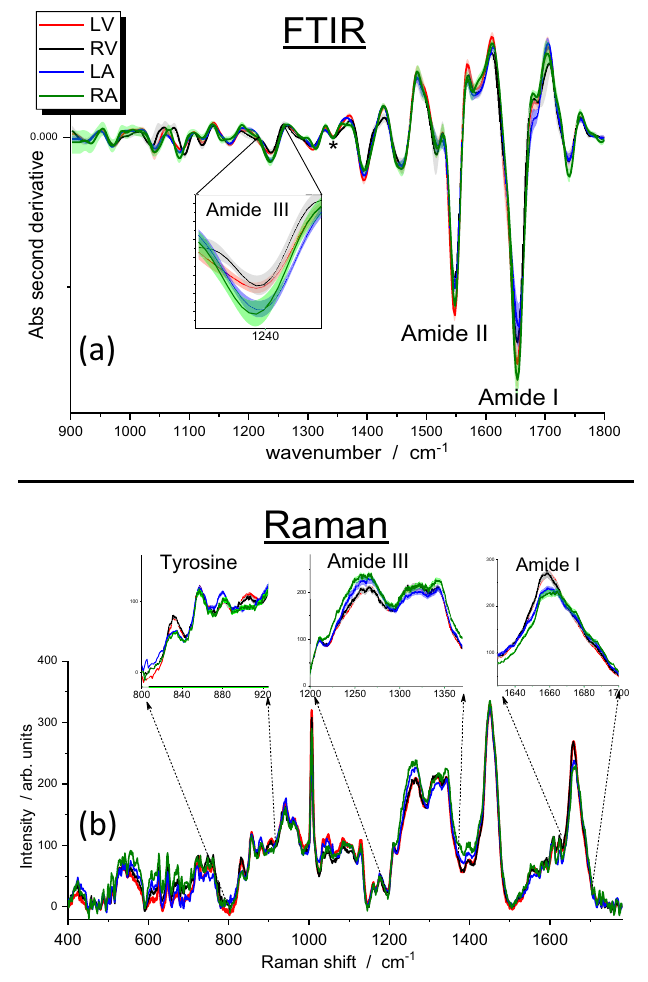
Figure 1. ( a ) Second-derivative FTIR spectra of the four heart chambers of normotensive Dahl/SS rats. The standard deviations of the different experimental profiles are represented by the shadowed areas. A magnification of the amide III region at about 1240 cm −1 is visualized in the inset. The asterisk marks the collagen band at approximately 1340 cm −135 ; we did not observe significant differences among the spectra of the four heart chambers. ( b ) Raman spectra of the four heart chambers of normotensive rats. The standard deviations of the different experimental profiles are represented by the shadowed areas. A magnification of the amide I, amide III and 800–900 cm −1 regions are visualized in the insets to evidence the differences between spectra from ventricles and atria. LV indicates left ventricle; RV, right ventricle; LA, left atrium; and RA, right